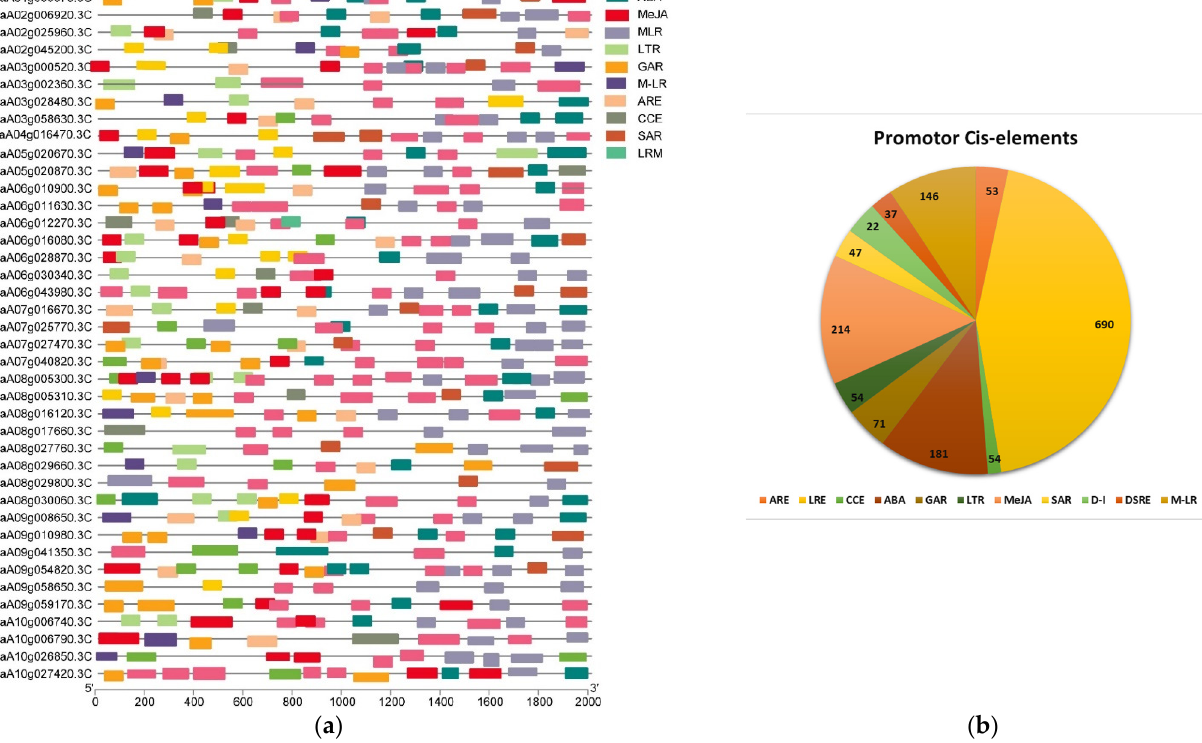
Figure 5. Identified cis-acting elements in the cyclin gene family. ( a ): cis-elements; Different hormone- and stress-responsive elements are linked to cis-elements in the promoters of the Brcyclin genes. Different colored boxes represent different cis-elements. ( b ): The pie chart shows the total identified elements and the number of each element in a specific color. Auxin responsive elements (ARE), light responsive elements (LRE), circadian responsive elements (CCE), abscisic acid (ABA), gibberellic acid-responsive elements (GA), low temperature-responsive elements (LTR), methyl jasmonate (MeJA), salicylic acid (SAR), drought inducible (D-I), defense and stress-responsive elements (DSRE), MYB binding site involved in light responsiveness (M-LR).